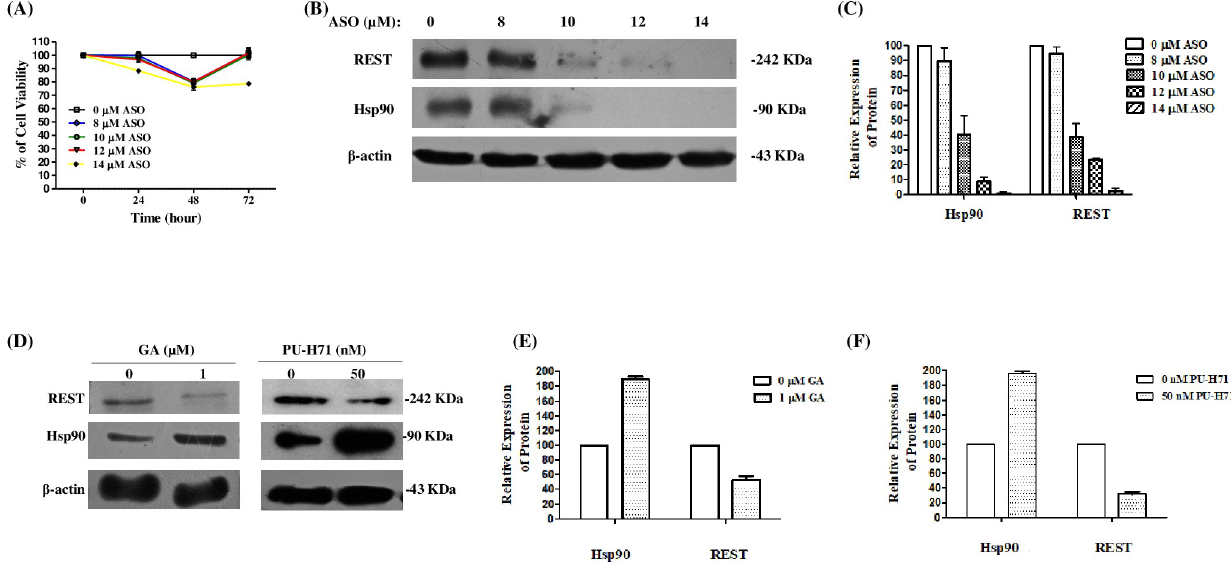
Fig 3. The decrease or inhibition of Hsp90 induced REST degradation. (A) Effect of Hsp90 α ASO on cell viability. Differentiated SH-SY5Y cells were transfected with different concentrations of Hsp90 α ASO. Cell viability was estimated after different periods (hours) by the MTT method. The viable cells’ 100% value was defined based on that obtained for non-transfected cells ( P < 0.0001). (B) Western blot analysis showed that the levels of REST and Hsp90 α dramatically reduced in a dose-dependent manner at 48 h because of Hsp90 α ASO. β -actin was used as a protein loading control. (C) The densitometry analysis of bands representing means ± SDs of three independent experiments ( P < 0.05). (D) The level of REST dramatically reduced in differentiated SH-SY5Y cells treated with GA (1 μ M) or PU-H71 (50 nM) at 24 h. (E) The REST level decreased by GA more than 50% and (F) PU-H71 more than 80%, respectively. The presented results correspond with three separate